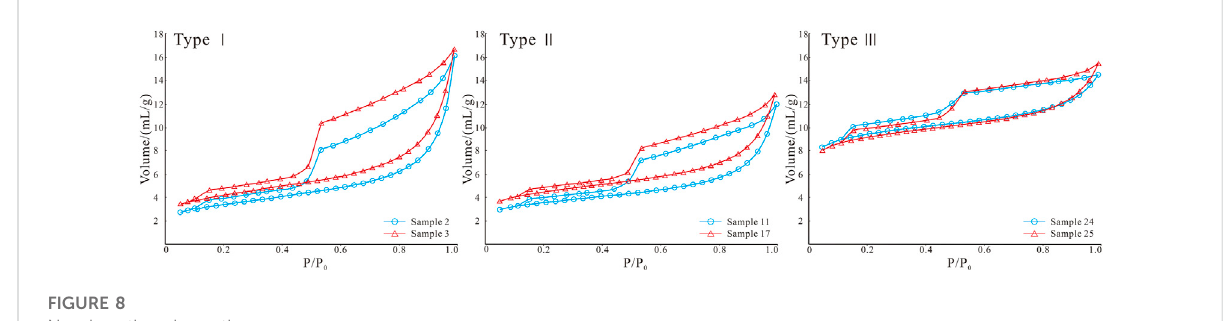
FIGURE 8 N 2 adsorption-desorption